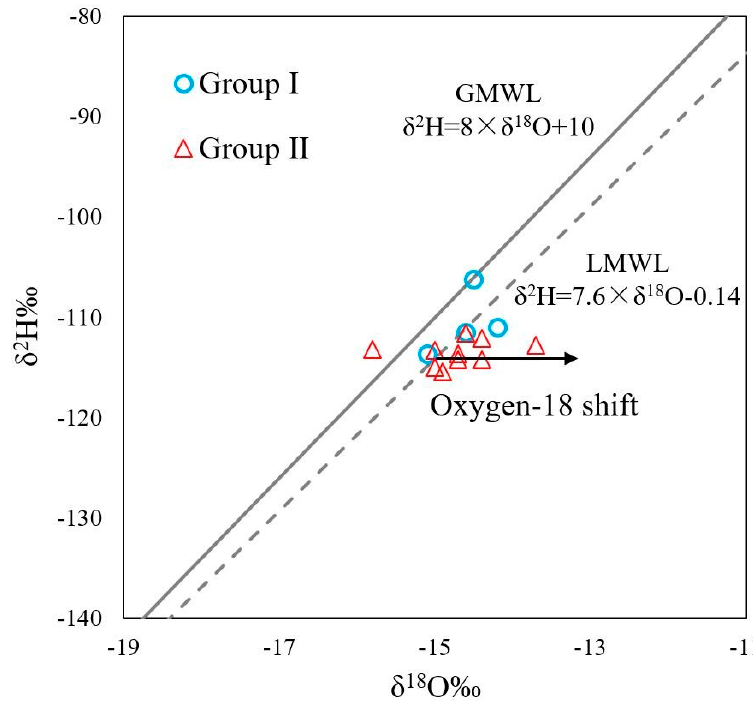
Figure 5. δ 2 H vs δ 18 O plot for water samples and the Global Meteoric Water Line (GMWL) and Local Meteoric Water Line (LMWL).